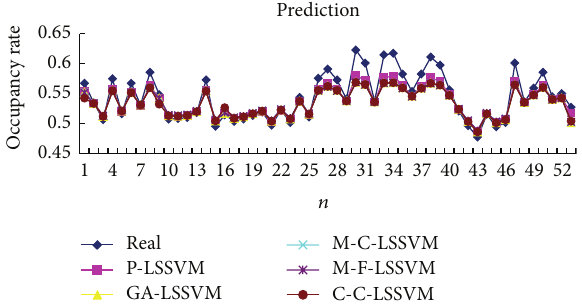
Figure 11: Five models predicted diagram for FM broadcasting band.